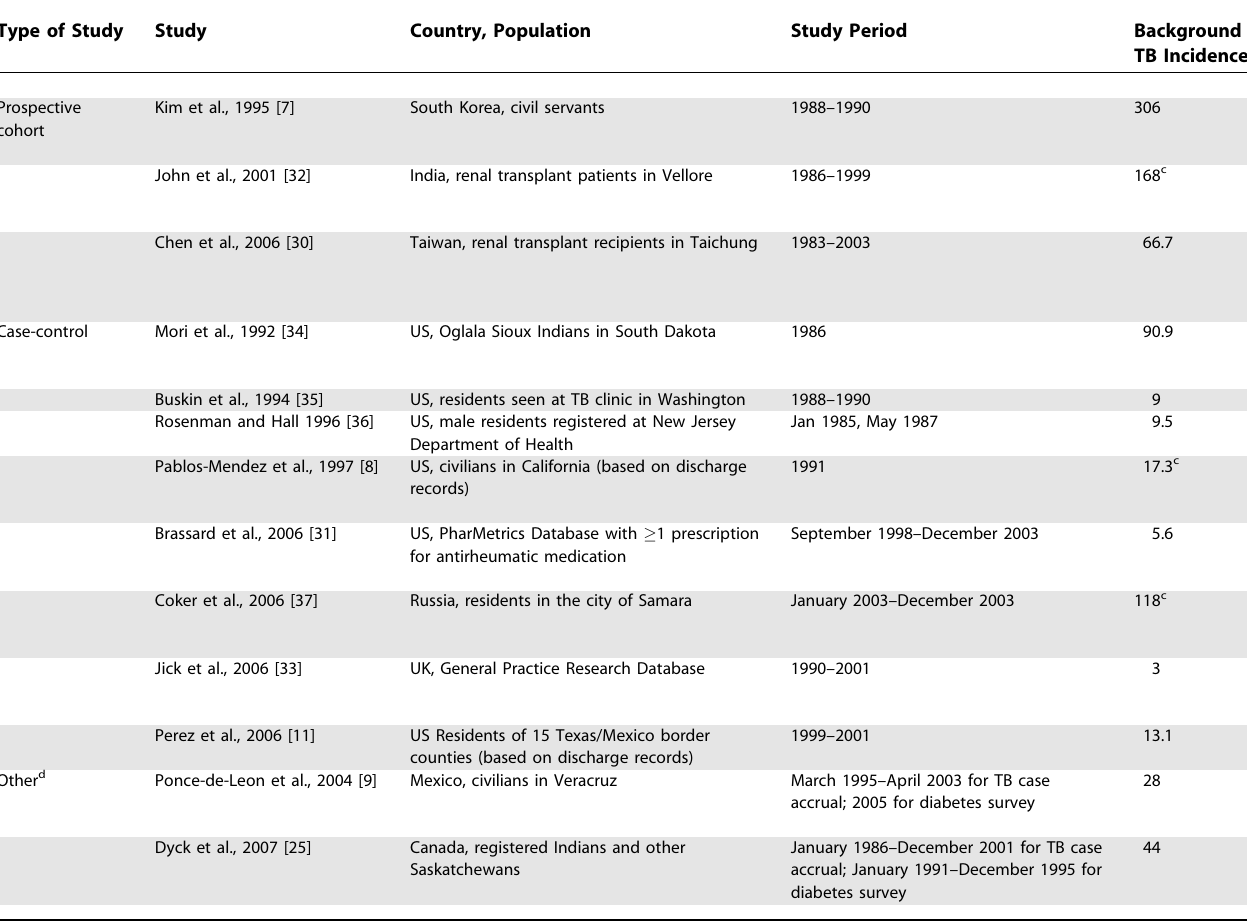
Table 1. Summary of the 13 Observational Studies of Association between Diabetes and Active Tuberculosis Included in the